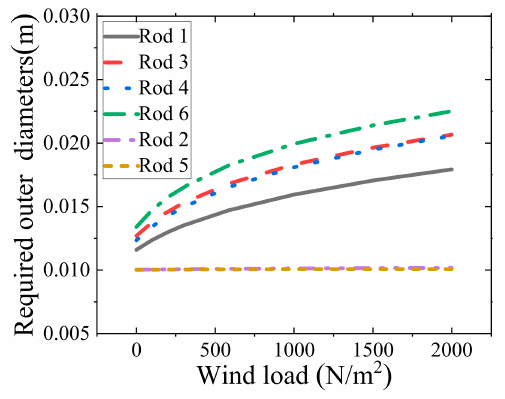
Figure 9. Required outer diameters of the rods as the wind load increases. Triangle brackets exhibit two different types of failure: yielding and buckling. Con- sidering rod 6 as an example, the required outer diameter is calculated separately under the yielding and buckling conditions, and referred to as D y and D b , respectively. The 6 6 calculation results are shown in Figure 10. Both D y and D b increase with increasing wind 6 6 load, and D b is much higher than D y , which indicates that rod 6 is more prone to buckling 6 6 than to yielding. The curves of D y and D b separate the figure into three areas, which 6 6 indicate three possible states of the triangular brackets: (1) when the outer diameter area of rod 6 is smaller than D y , the structure is prone to yielding or buckling failure; (2) when the 6 outer diameter area of rod 6 is higher than D y but lower than D b , the structure is prone 6 6 to yielding failure; and (3) when the outer diameter area of rod 6 is higher than D b , the 6 structure is safe under the given wind pressure.